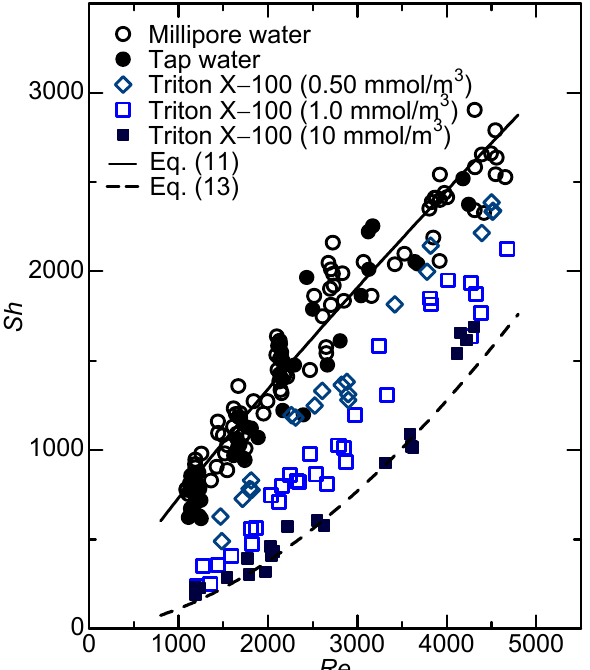
Fig. 8 Sherwood number of a bubble in stagnant waters.